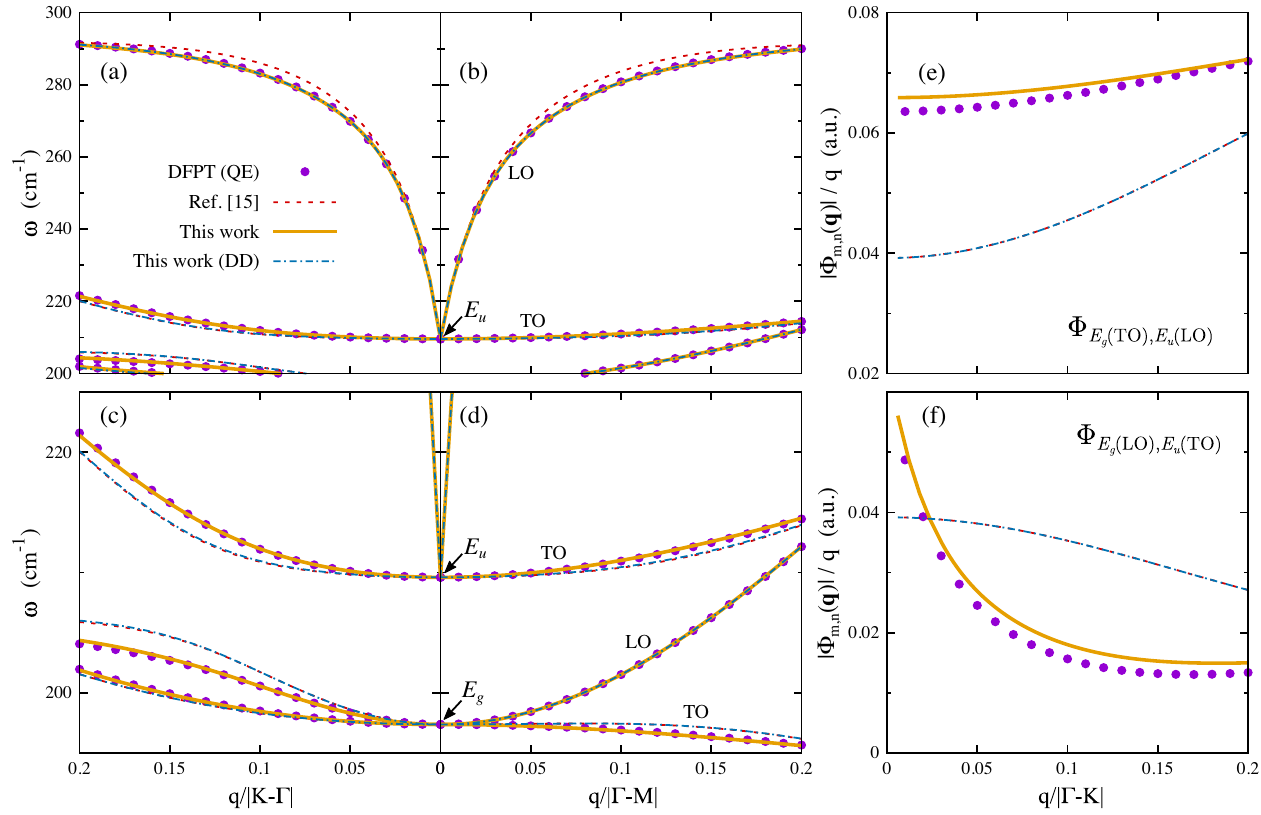
FIG. 6. SnS 2 . (a),(b) Dispersion of the optical E 2D Brillouin zone. (c),(d) Dispersion of the lower-energy E Interpolations are performed on a grid of 8 × 8 in-plane q points. (e),(f) Elements of the Γ -mode representation of the force-constant matrix corresponding to the E j q j are